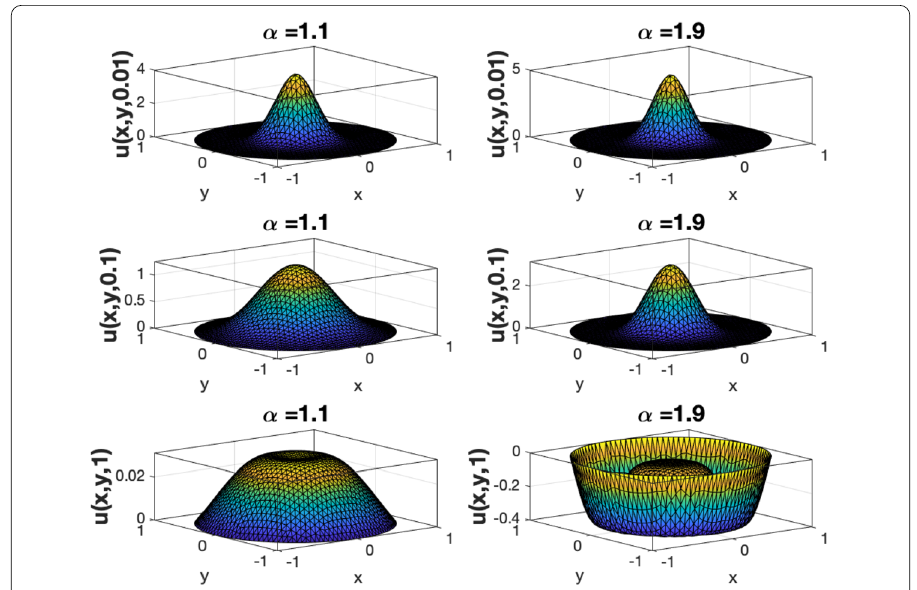
Figure 2 Comparison behavior of u ( x , y ,0.01), u ( x , y ,0.1) and u ( x , y ,1) for (1.1) with fixed κ = 1 and different α , computed by SBD scheme with h = 0.05, N =